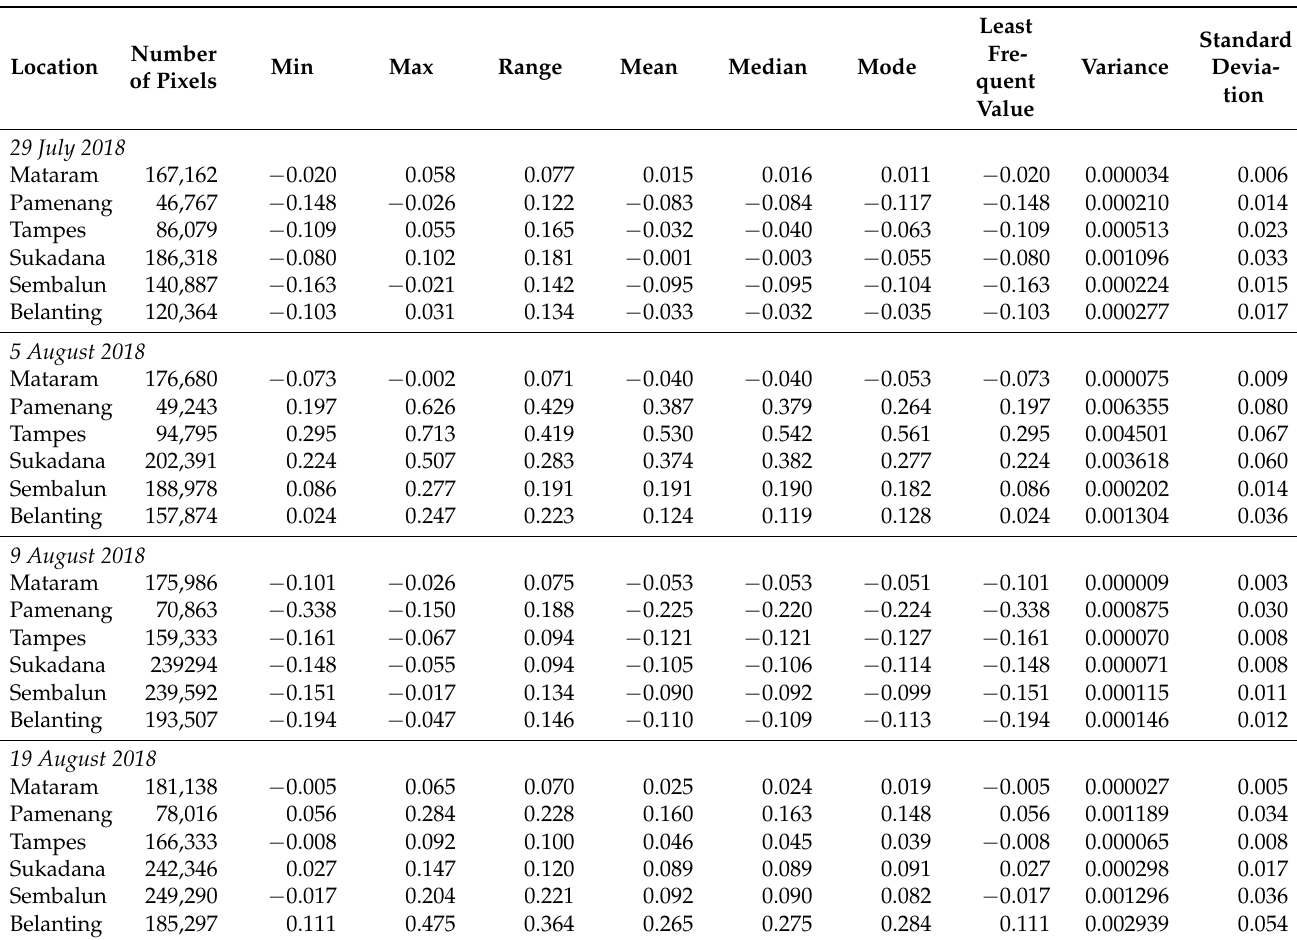
Table 2. Zonal statistics of displacement due to earthquakes in selected areas (Mataram city, Pamenang, Tampes, Sukadana, Sembalun, and